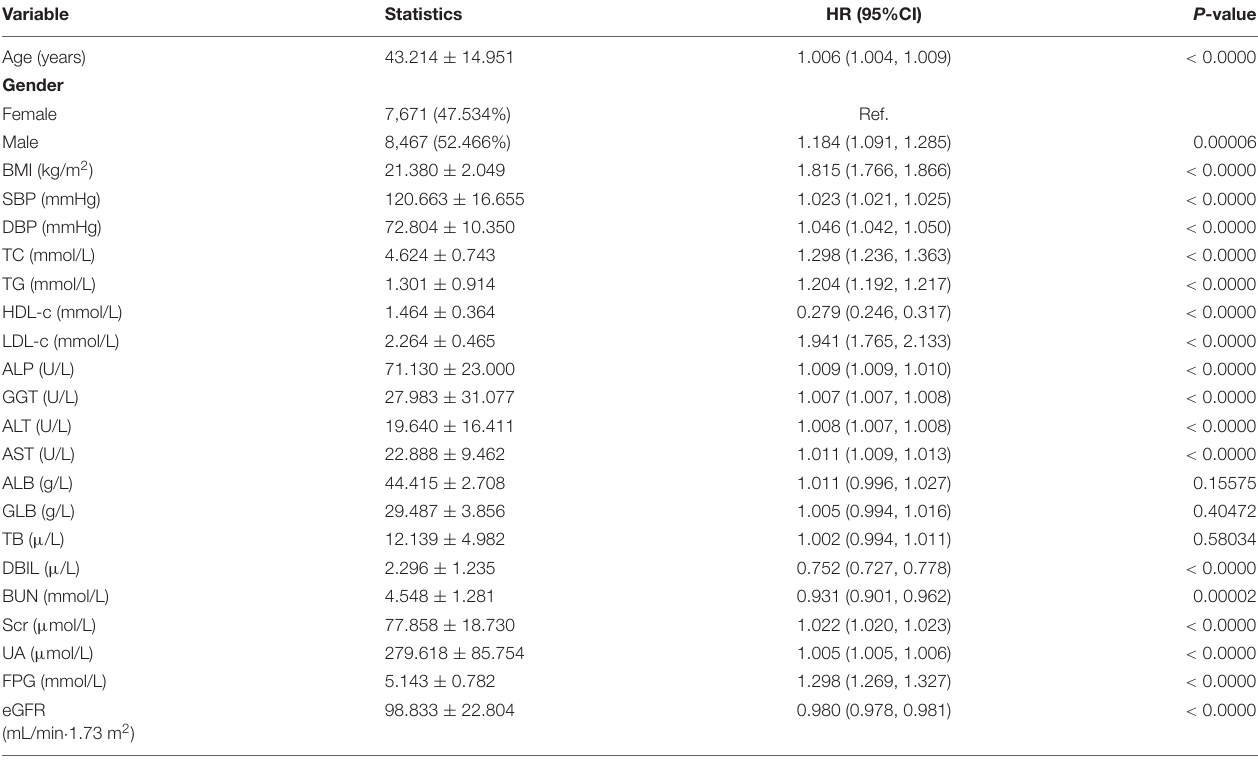
TABLE 3 | The results of univariate Cox proportional hazards